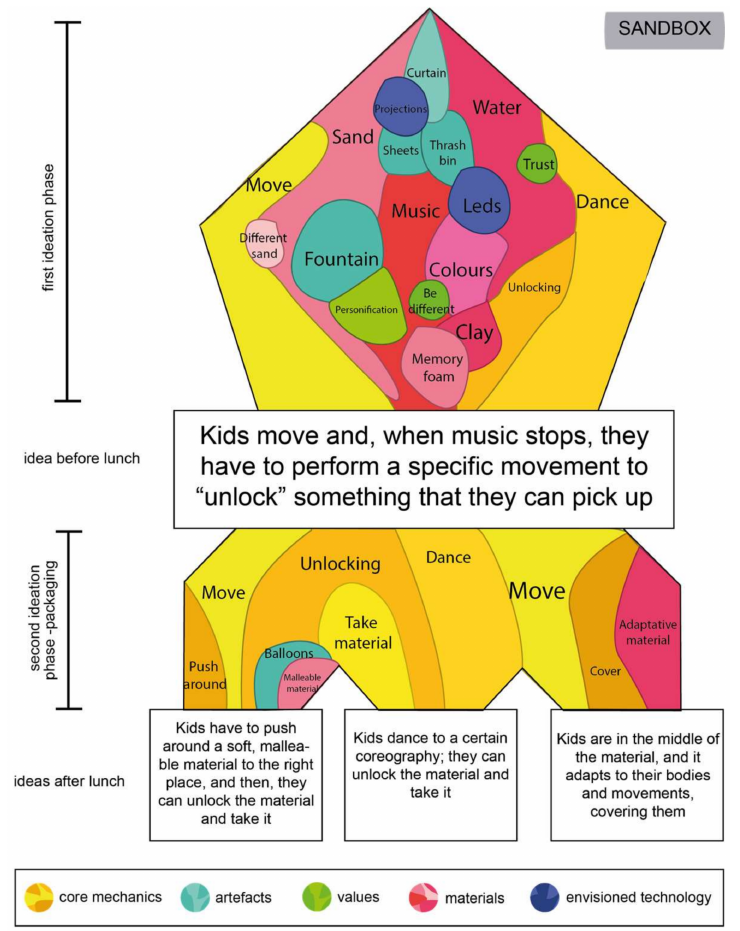
Figure 9. Double Diamond variation of the scenario “sandbox” using a more qualitative form. The Supplementary Materials include a version of these images that can be